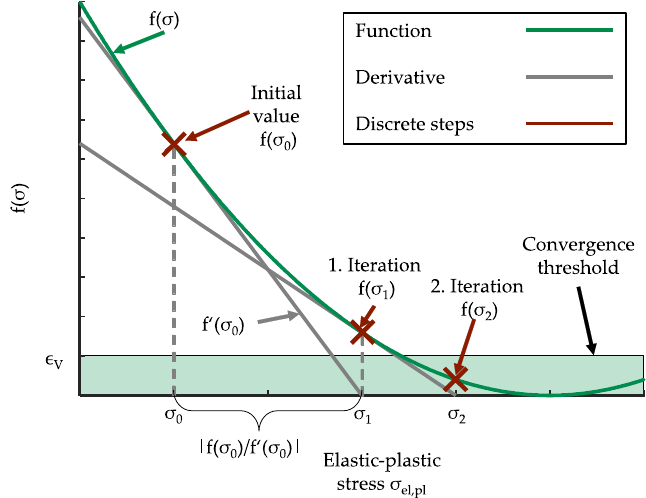
Figure 4. Visualization of the Newton termination criterion “falling below a value”.